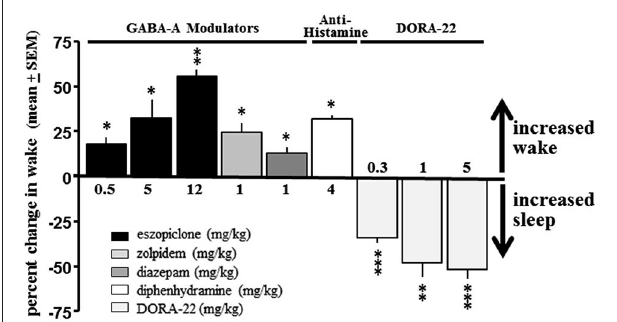
FIGURE 2 | DORA-22 promotes sleep in beagle dogs . GABA-A receptor modulators (eszopiclone and zolpidem) and antihistamine (diphenhydramine) produce paradoxical hyperarousal but DORA-22 induces sleep in dogs. Only DORA-22 was thereby assessed for salience-gated arousability and compared to unmedicated healthy sleep in dogs. Data expressed as mean percentage change ± SEM from vehicle during the first 2 h post-dose during the daytime active period. * p < 0.05; ** p < 0.01; *** p <